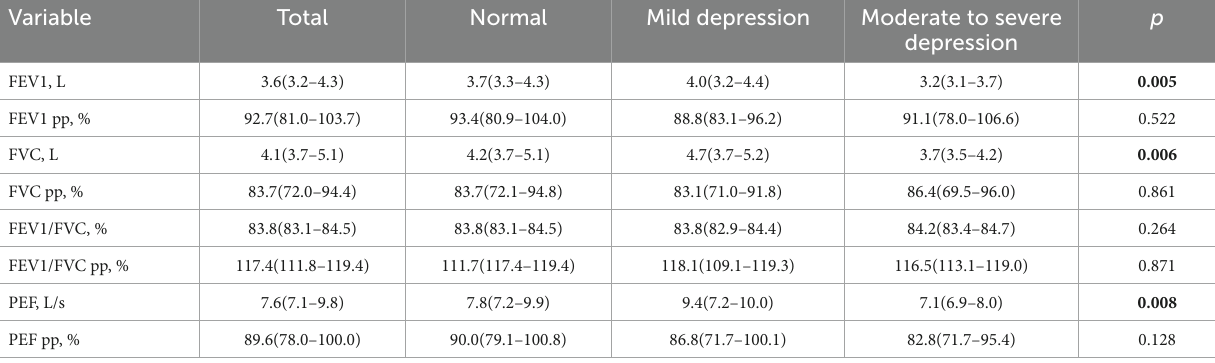
BMI, body mass index. Continuous variables are expressed as medians and 25th and 75th percentiles, and categorical variables are expressed as frequencies and percentages, n (%). Kruskal-Wallis tests, chi-square tests or Fisher exact tests were used for comparisons of baseline characteristics among the different levels of depression. Bold values indicated the results were statistically significant, with the two-tailed tests with p -values <0.05. TABLE 2 Lung function of college students by level of